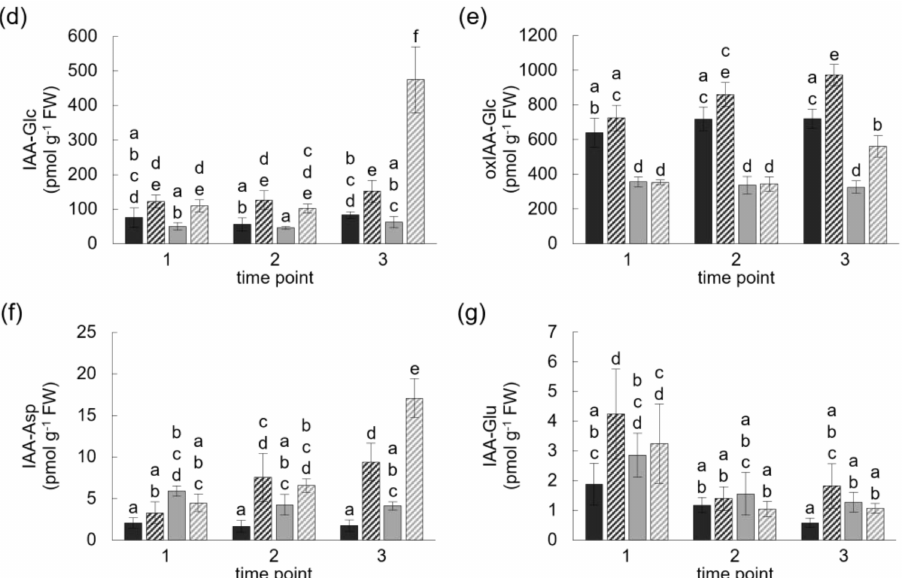
Figure 3. Photoperiod stress causes an increased concentration of IAA, IAA-Glc and IAA-Asp in wild-type and ahk2,3 plants. ( a ) Schematic overview of sampling time points (arrowheads) for IAA measurements. Five-week-old wild-type plants were either cultivated under SD conditions (control) or were exposed to a prolonged light period of 32 h (PLP). (B–G) Concentration of free IAA ( b ), oxIAA ( c ), IAA-Glc ( d ), oxIAA-Glc ( e ), IAA-Asp ( f ) and IAA-Glu ( g ) in control samples and PLP samples at the time points depicted in ( a ). Letters indicate significantly different statistical groups ( p ≤ 0.05; two- way ANOVA; n ≥ 3). Error bars indicate SD. IAA, indole-3-acetic acid; oxIAA, 2-oxoindole-3-acetic acid; IAA-Glc, IAA-glucose; IAA-Asp, IAA-aspartic acid; IAA-Glu, IAA-glutamic acid. Exact values are depicted in Supplementary Table